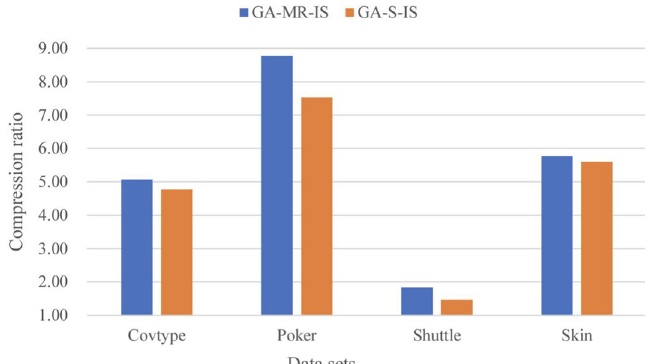
Fig. 8 The comparison of the compression ratio of two implementations